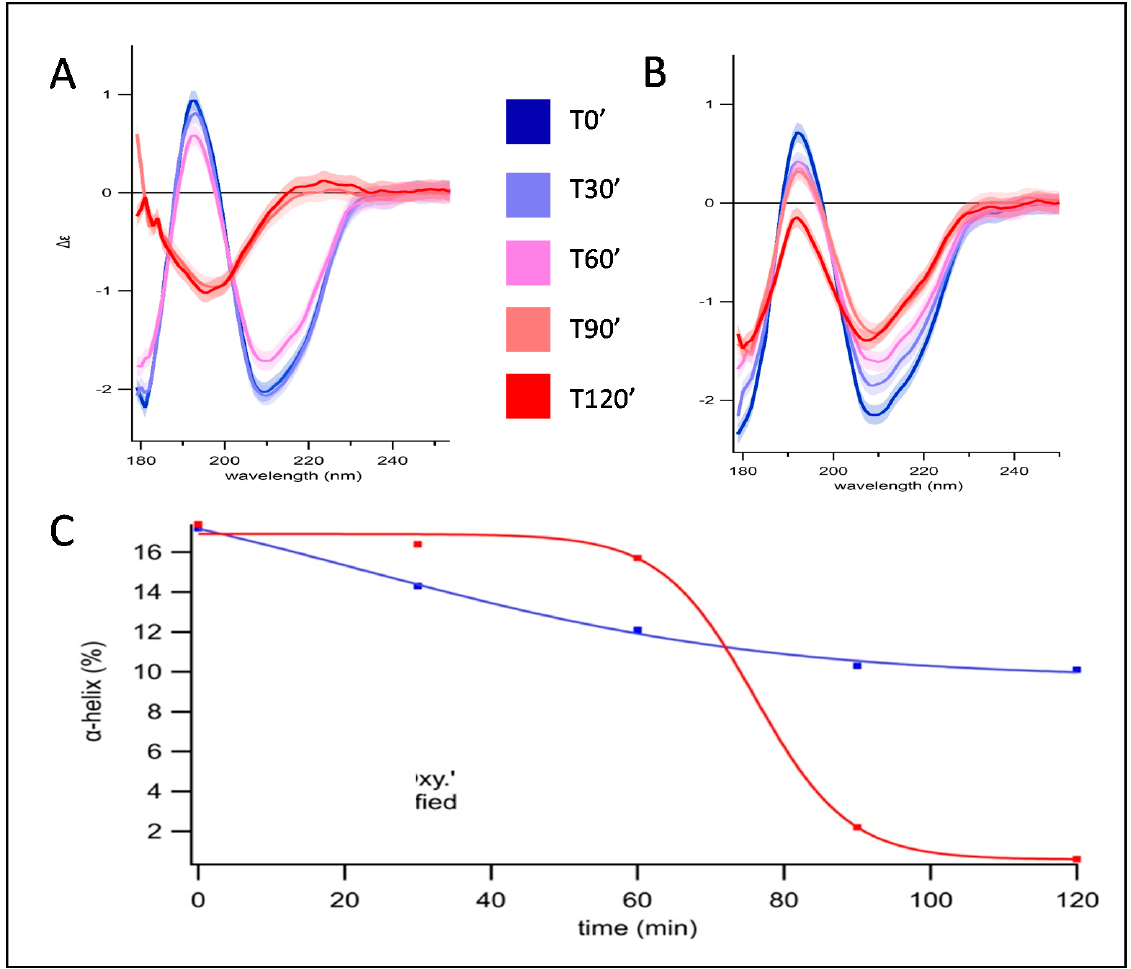
Figure 1. SRCD spectra of pepsin ( A ) and oxidized pepsin at 3 mM FeSO4/DETAPAC/H2O2 ( B ). The kinetic of gastric